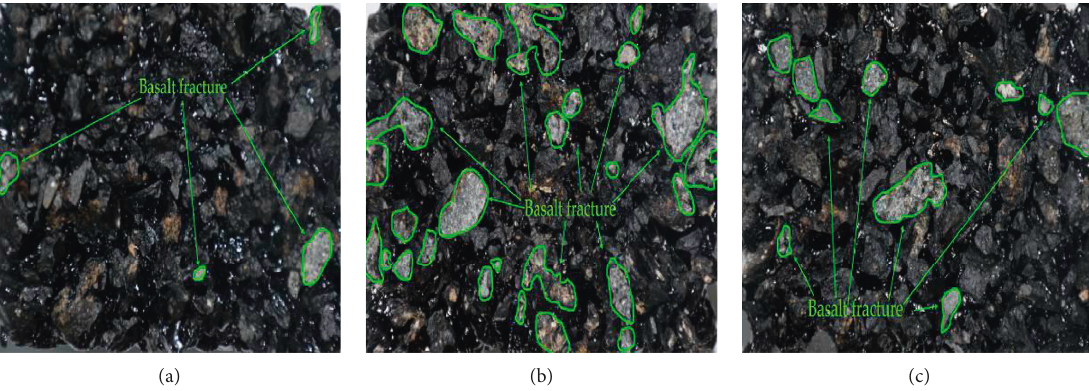
Figure 15: Typical sections of samples with fibers of 9mm +0.3%. (a) 5 ° C. (b) − 5 ° C. (c) − 15 °